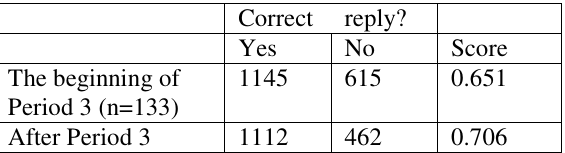
Table 3. A comparison of the results based on log-data from the four versions of a course in basic logic. Only the content of Period 3 of the course has been changed from year to